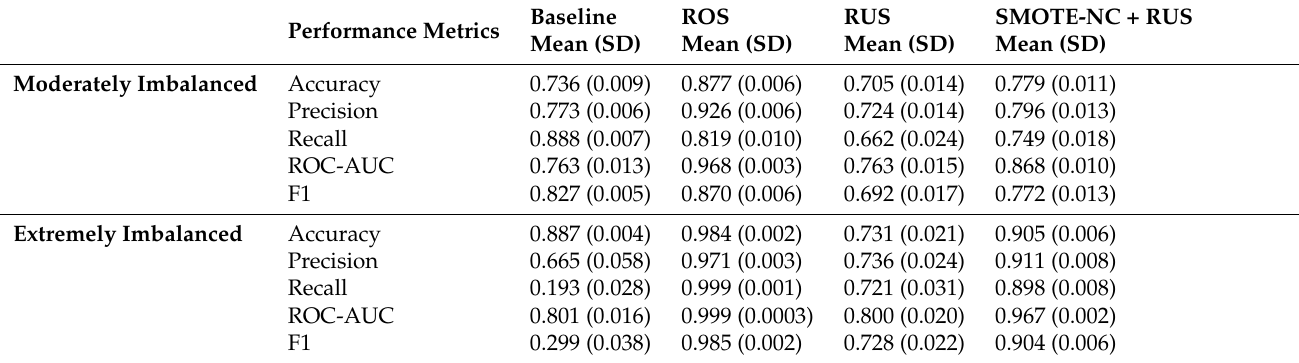
Table 4. Classification results for each resampling